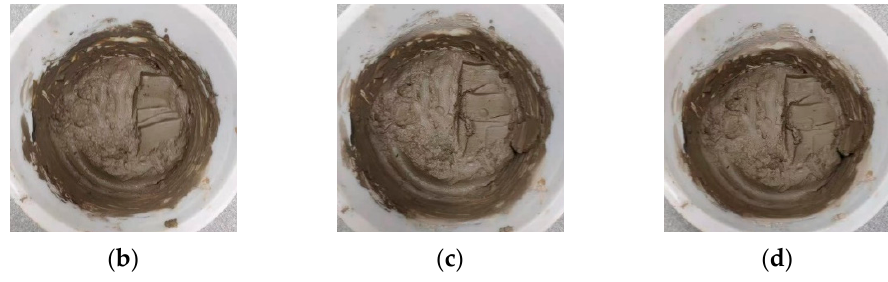
Figure 3. Curing effect of cement solidified soil: ( a ) After 0.5 h; ( b ) After 1 h; ( c ) After 3 h; ( d ) After 6 h.